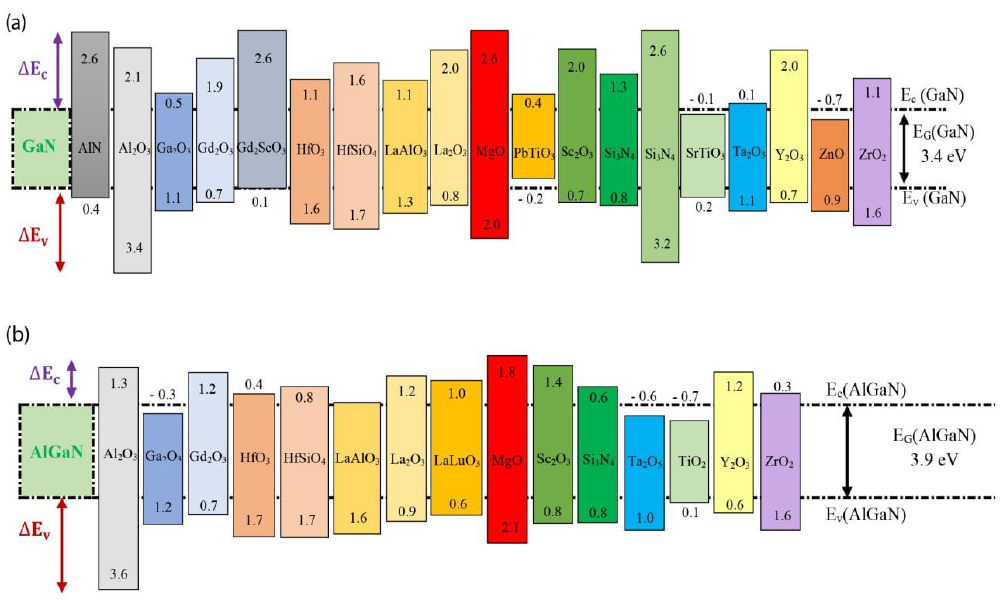
Figure 25. Various dielectric materials regarding ( a ) GaN [100] and ( b ) Al 0.3 Ga 0.7 N [101] have different valence and conduction band offsets ( ∆ E V and ∆ E C ).